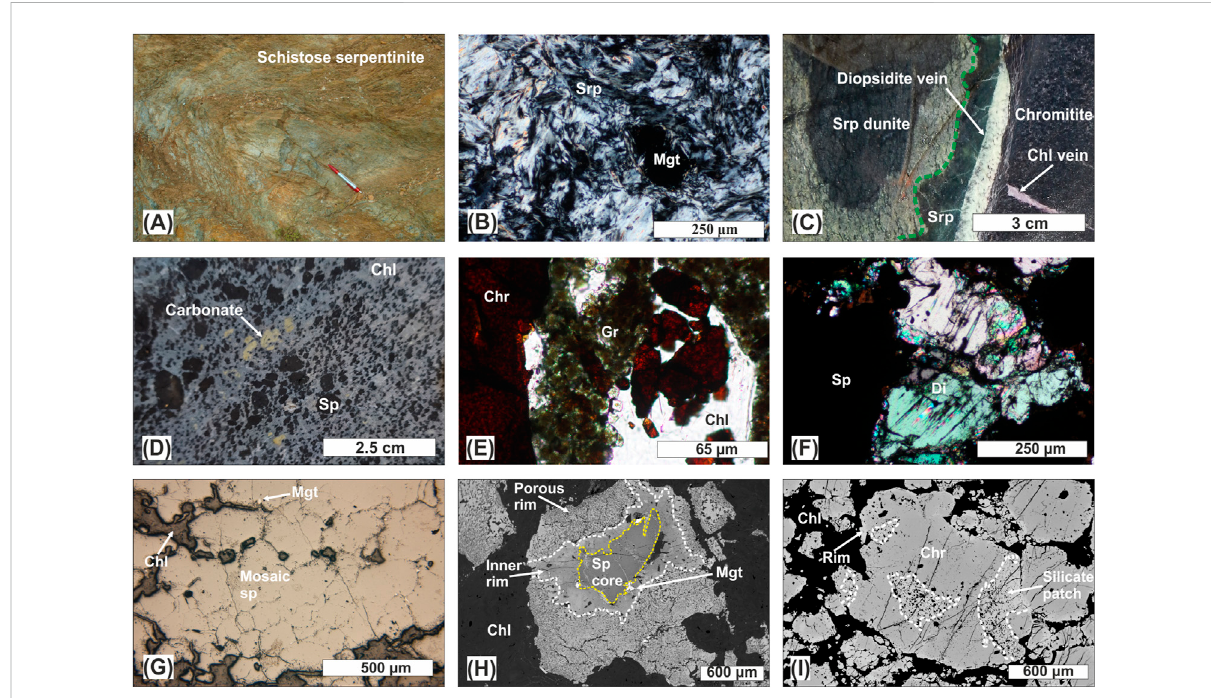
FIGURE 2 (A) Schistose serpentinite. (B) Photomicrograph of serpentinite comprised of fl aky serpentine and magnetite. (C) Massive G1 chromitite cross- cut by chlorite veins. The host rock consists of serpentinized dunite and along the contact between the ore and the host fl aky green-colored serpentine is developed along with a tectonized diopsidite vein consisting of titanite-diopside-chlorite. (D) Sheared and foliated disseminated chromitite from Gomati with dispersed carbonates. (E) Photomicrograph of shear zone fi lled with green-color garnet. (F) Photomicrograph of G1 chromitite composed of diopside interstices with spinel inclusions. (G) Photomicrograph of mosaic textured spinel (G1 chromitite). (H) B.S.I. of altered spinel grain (G1 chromitite) consisting of an outer porous rim followed bysolidinner rim and dark colored pristine core. Cracks are fi lled